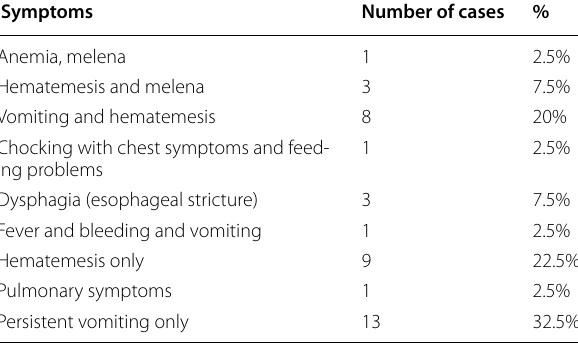
Table 2 Presentations of GERD in the studied